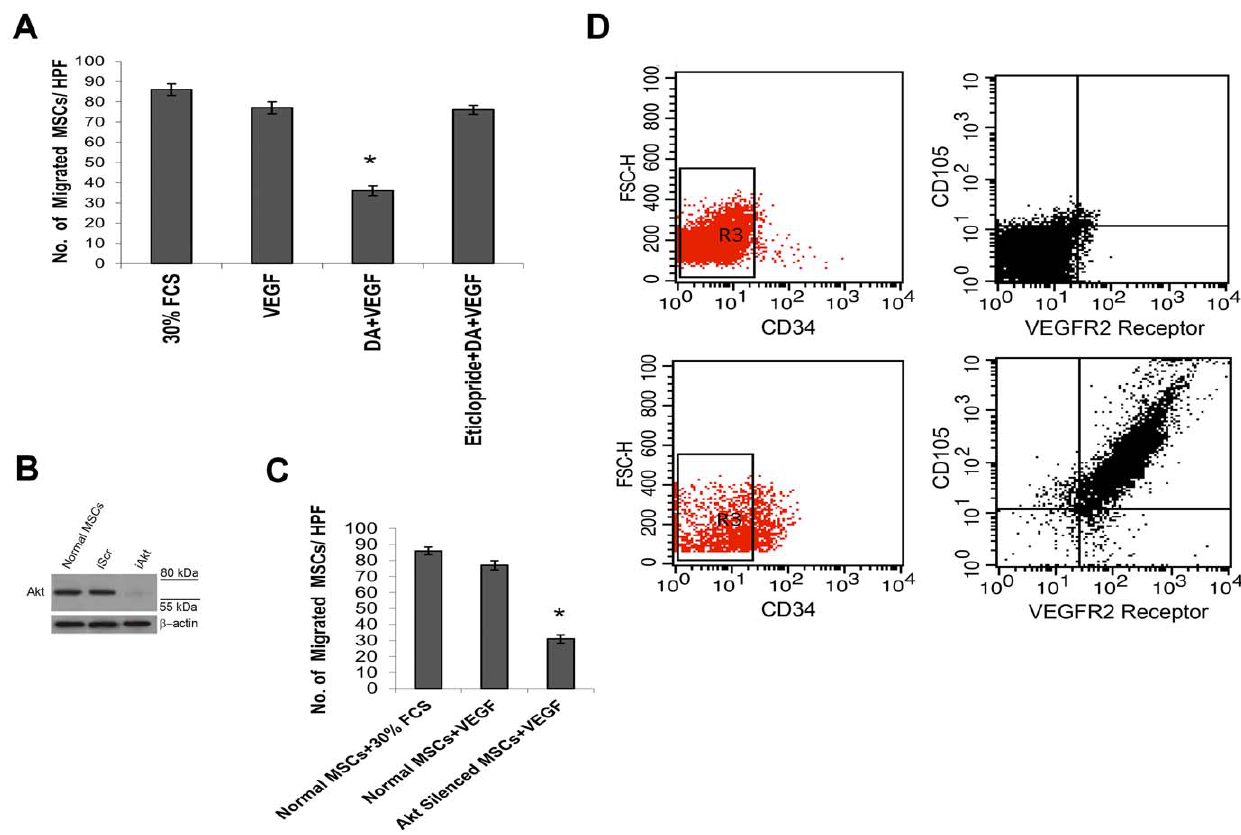
Figure 4. VEGF regulates migration of murine BM-MSCs through activation of Akt. ( A ) Effects of VEGF on in vitro migration of MSCs in transwell chambers. After incubation with MSCs at 37 u C for 24 hours, VEGF was added. After overnight incubation cells remaining on the upper face of the filters were removed with a cotton wool swab and migrated cells that remained on the lower face of the filters were stained with Gill’s Haematoxylin, counted and photographed. Numbers of migrated cells were counted in 10 high-power fields (HPFs) after subtraction of the basal migration observed in the presence of DMEM alone (without presence of any growth factor). Dopamine (DA) significantly inhibits VEGF induced migration of MSCs (*, P , 0.05), whereas when cells were pre-treated with 100 m M eticlopride (a specific DA D 2 receptor antagonist), the inhibitory effect of 1 m M DA on VEGF mediated mobilization was abrogated. Results are representative of six separate experiments each yielding similar results. ( B ) Silencing of Akt in MSCs by siRNA transfection. After 48 hours of transfection, no expression of Akt was found in MSCs transfected with Akt siRNA (iAkt) whereas control MSCs in which control siRNA containing scrambled sequence (iScr) was transfected showed similar expression of Akt as normal non-transfected MSCs. ( C ) Effect of Akt silencing on VEGF induced migration of MSCs in a chemotaxis assay. Numbers of migrated cells were counted in 10 high-power fields (HPFs) after subtraction of the basal migration observed in the presence of DMEM alone (without presence of any growth factor). Silencing of Akt significantly inhibits VEGF induced migration of MSCs (*, P , 0.05). Results are representative of six separate experiments each yielding similar results. ( D ) Flow cytometric analysis of VEGFR-2 receptors in murine MSCs. To confirm that CD34 2 CD45 2 CD105 + cells express VEGFR-2 receptors, CD34 2 cells were selected from in vitro expanded Lin neg bone marrow cell population (containing CD45 2 , CD11b 2 cell populations) and these CD34 2 CD45 2 cells were evaluated for presence of CD105 and VEGFR-2 receptors. Results showed that almost 89% cells of the total MSC population (CD34 2 CD45 2 CD105 + cells) express VEGFR-2 receptors on their